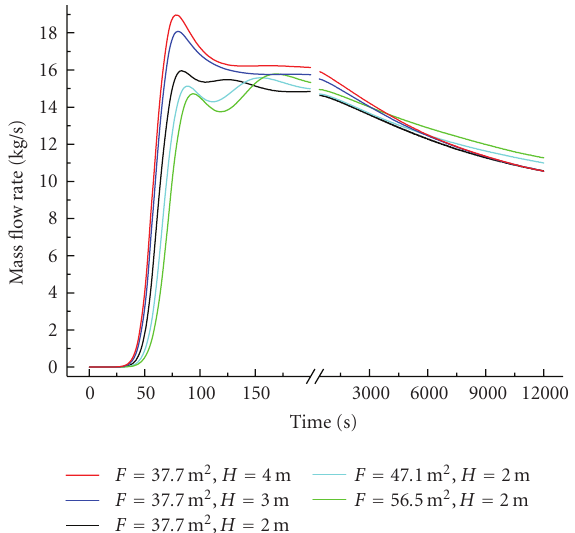
Figure 9: Outlet fluid temperature in the heat exchanger of the secondary loop with di ff erent height di ff erences and heat transfer areas.